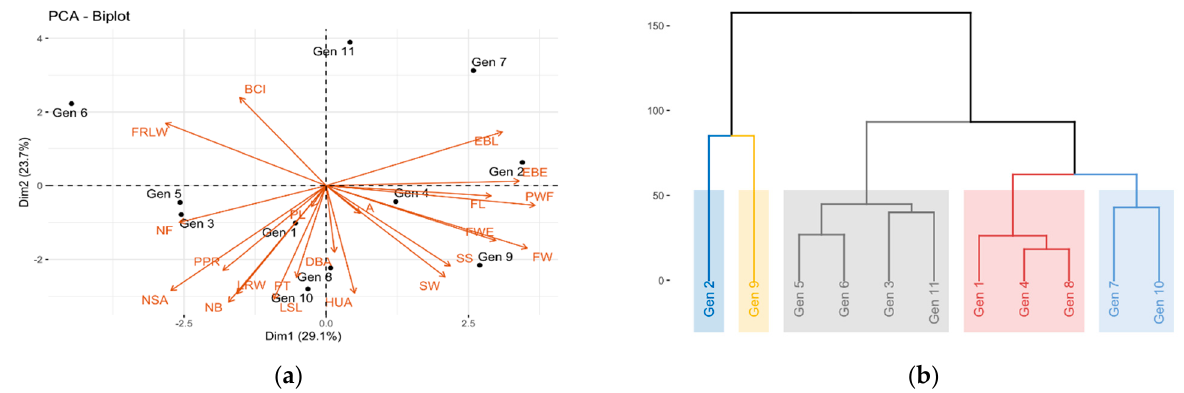
Figure 2. ( a ) Principal component analysis biplot. ( b ) Hierarchical cluster analysis of yellow pitahaya fruit genotypes.